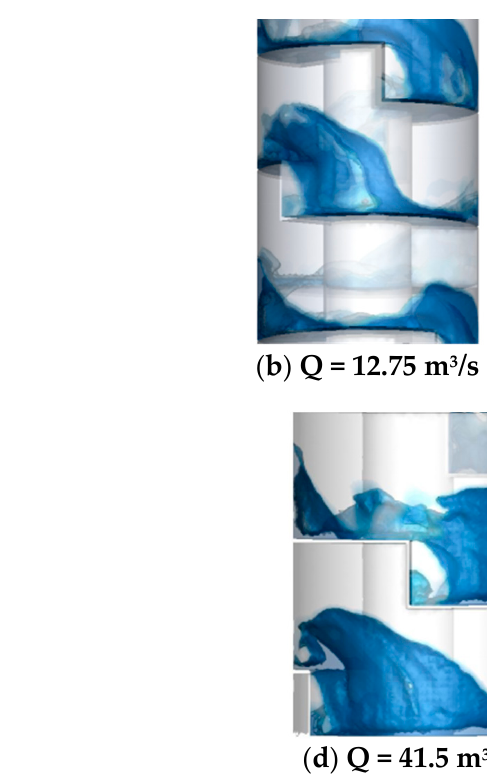
( e ) Figure 2. Grid convergence index value for different grid densities: ( a ) location of radial line; ( b )